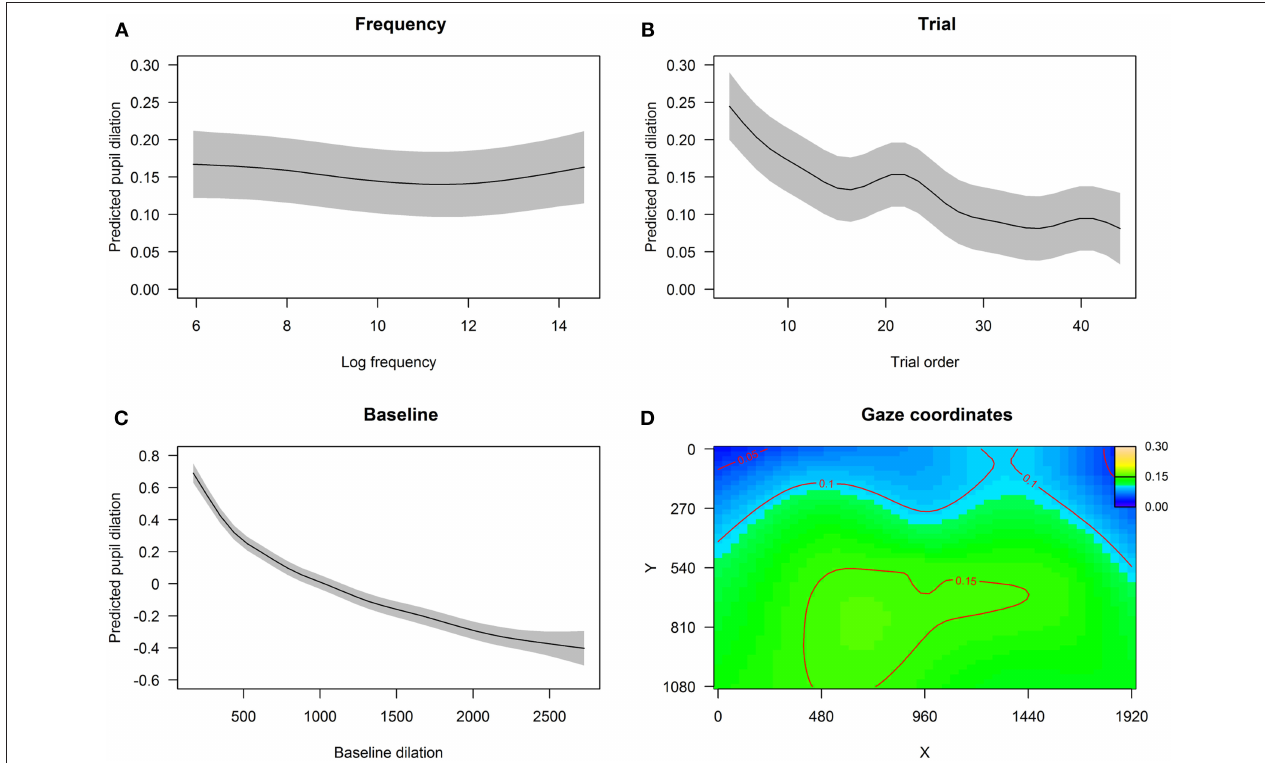
FIGURE 1A | Visualization of the effect of control variables on pupil dilation values predicted by the model: (A) Log word frequency, (B) Trial order, (C) Baseline dilation, (D) Gaze coordinates (X and Y). Note that the scale in (C) is different due to the size of the